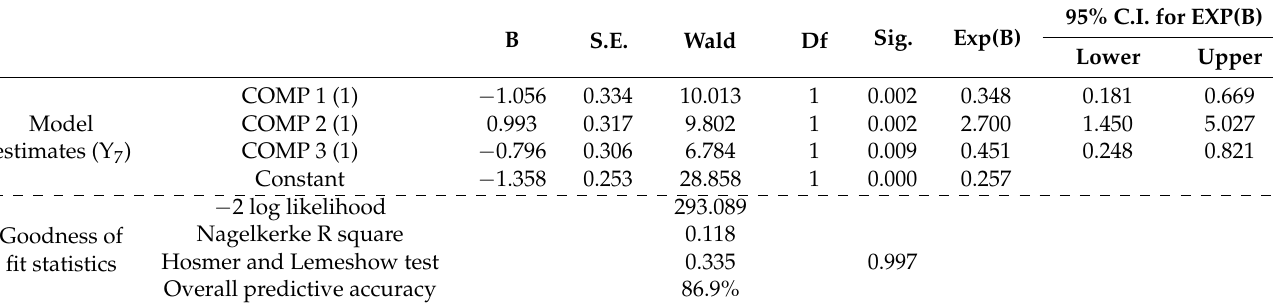
Table 13. Multivariate regression results between high expenditure on alternative energy sources and predictor variables. B S.E. Wald Df